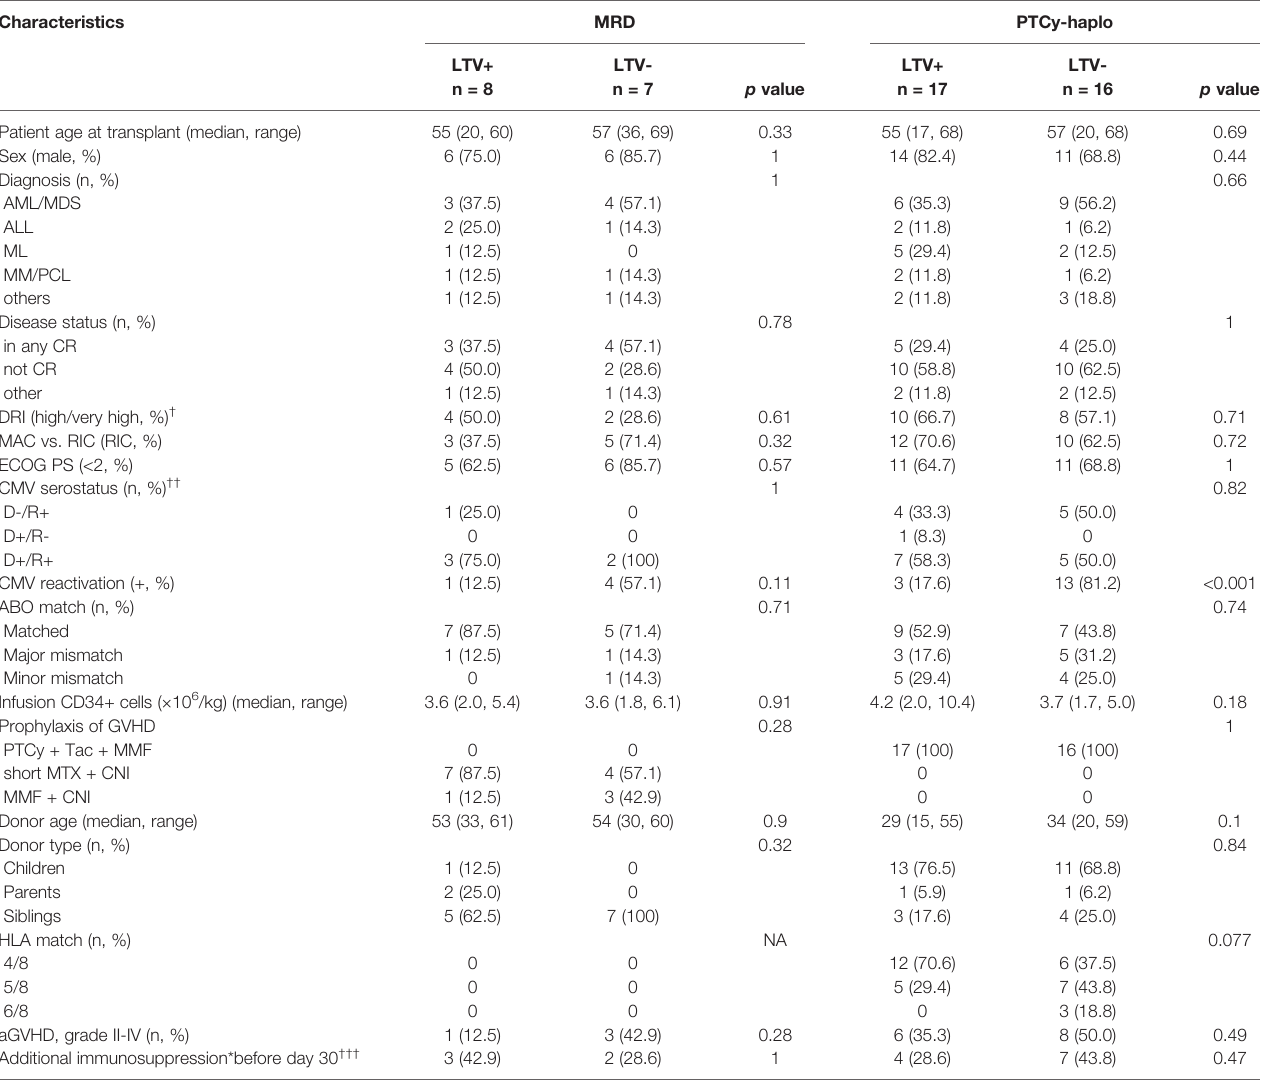
TABLE 1 | Patients ’ baseline characteristics. Characteristics MRD PTCy-haplo